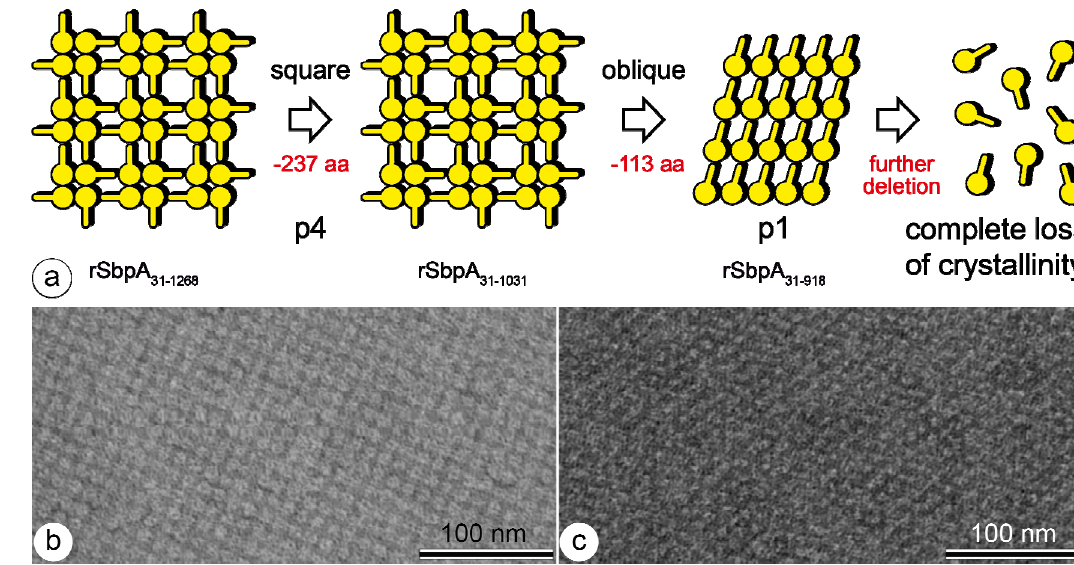
Figure 2. ( a ) Schematic drawing of the conversion of the S-layer lattice symmetry of SbpA, from square to oblique, and complete loss of crystallinity; ( b ) TEM image of the lattice showing square, and ( c ) of the rSbpA rSbpA 31–1268 lattice